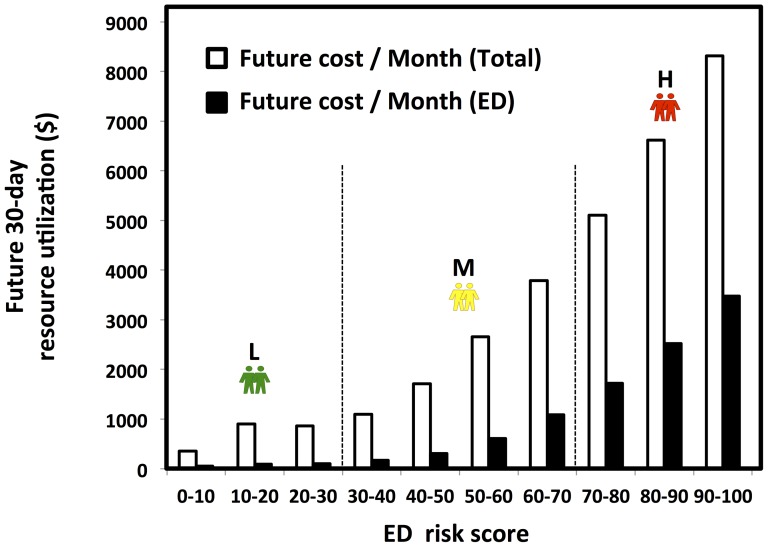
Future 30-day resource utilization analysis as a function of the ED risks.PMP1M: per member per 1 month. Two vertical lines serves as the boundaries between low, medium, high ED revisit risks.